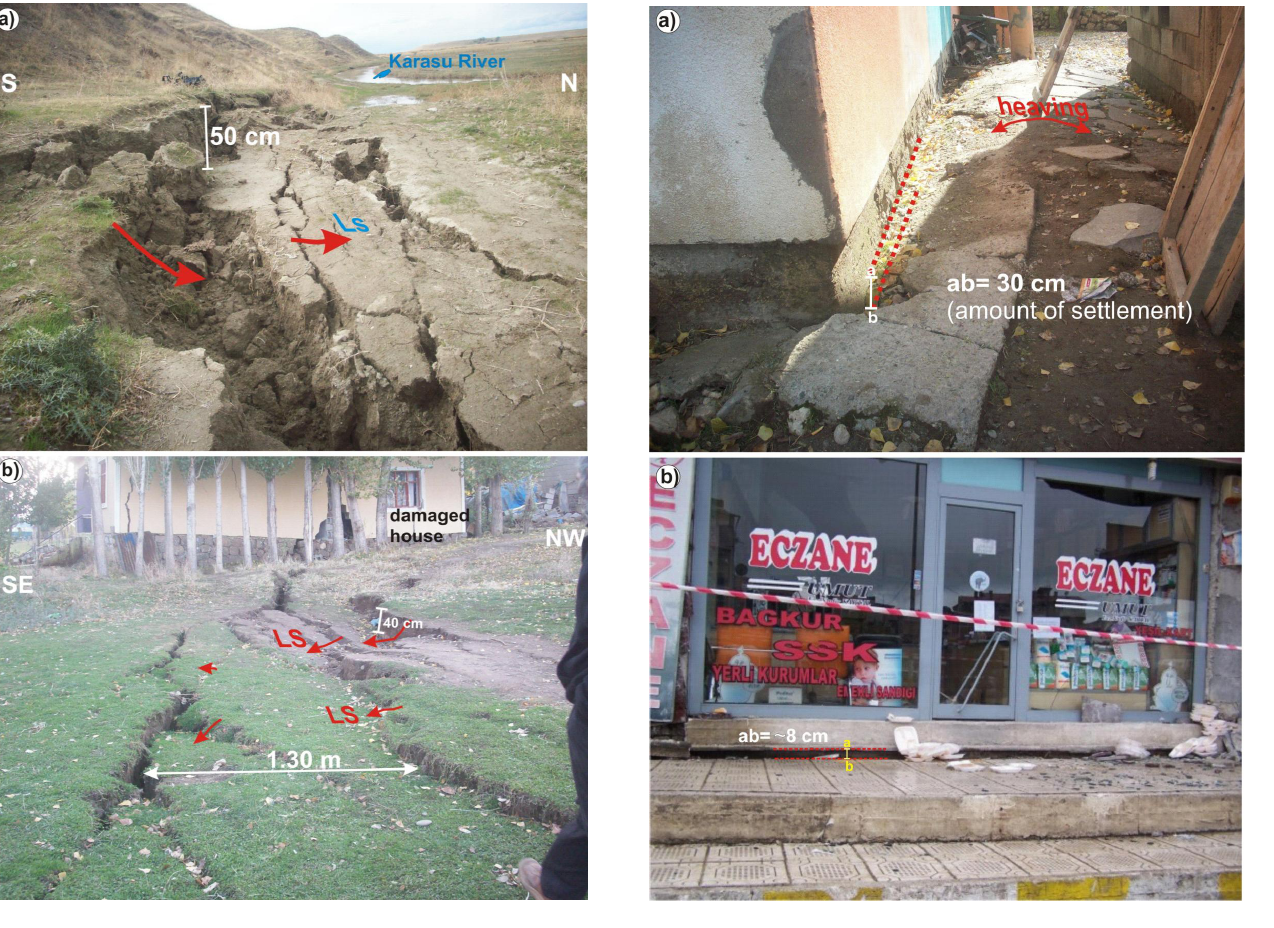
Figure 11. (a) Lateral spreading developed around the shore of Karasu River in Karasu Delta 3 Fig. 11. (a) Lateral spreading that developed around the shore of (b) Lateral spreading developed under a house in Çelebibağı, Erçiş. 4 Karasu River in Karasu Delta and (b) lateral spreading that devel- oped under a house in C¸elebiba˘gı, Erc¸is¸.